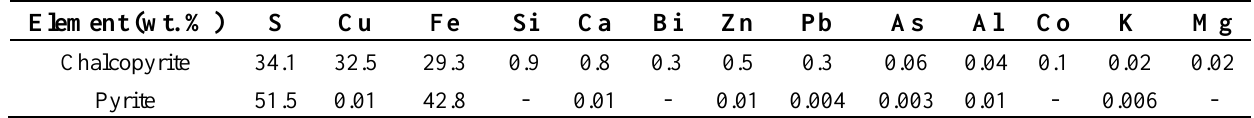
Table 1. Elemental composition of chalcopyrite and pyrite samples. Element (wt.